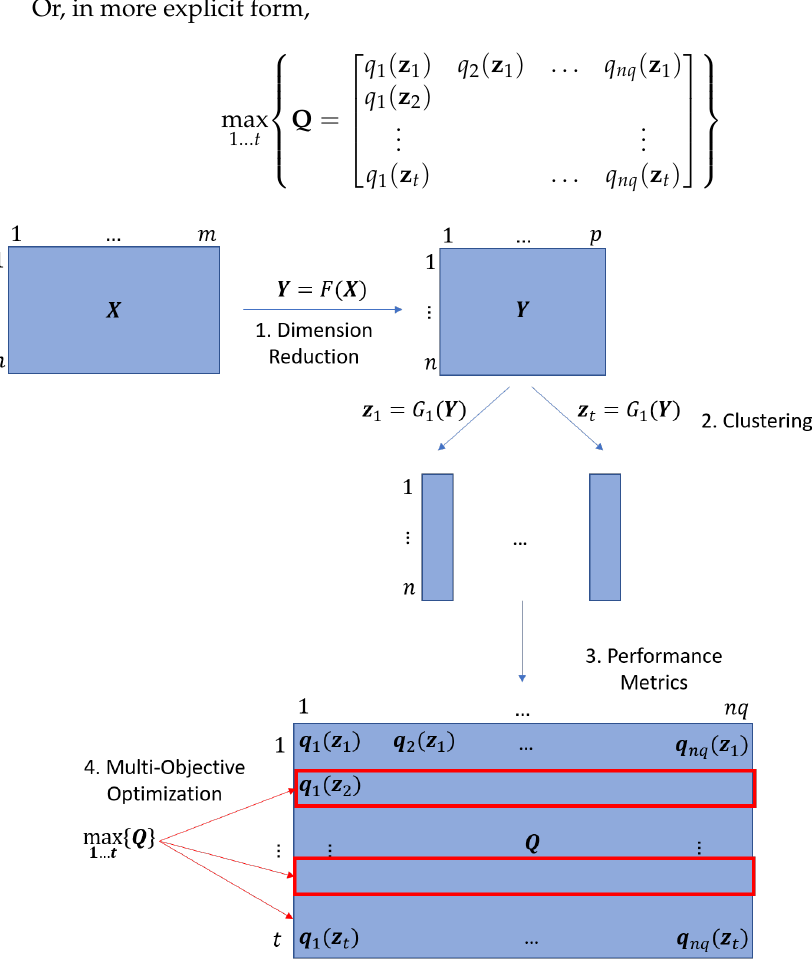
Figure 1. The schematic representation of the proposed methodology with its four main steps: dimension reduction, t types of clustering, the characterization of the clustering solutions by nq metrics and the selection of the best